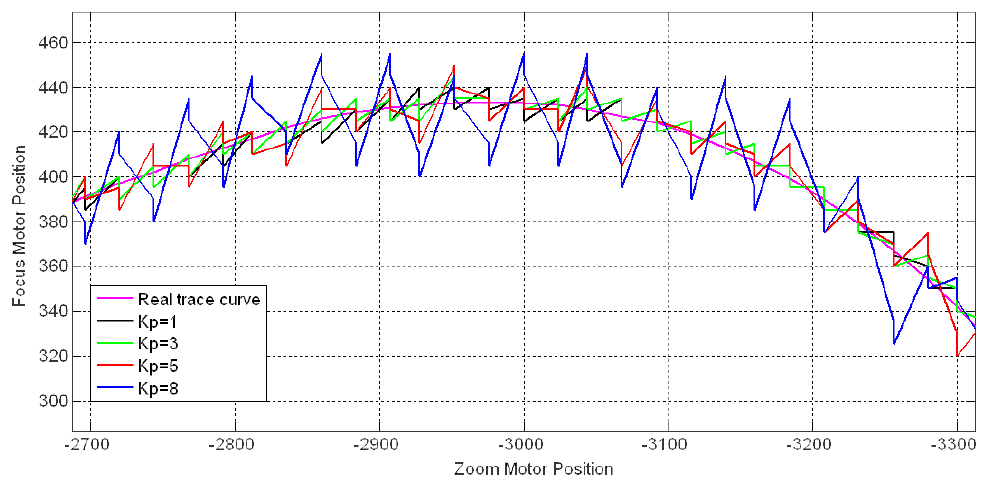
Figure 20. Feedback response curves for different proportional gains.